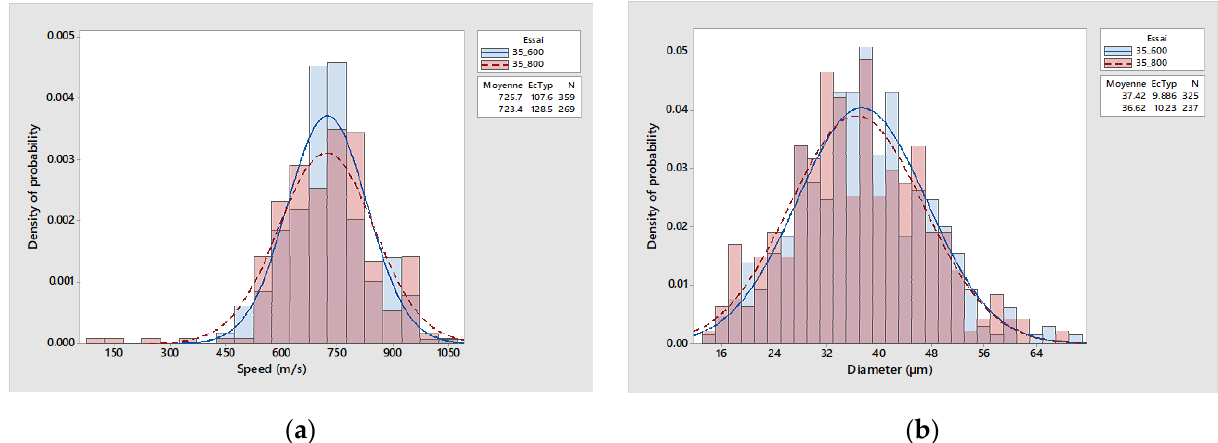
Figure 4. ( a ) Ti 3 AlC 2 particle velocities distribution; ( b ) the corresponding particle density distribution for 3.5 MPa gas pressure and different gas temperatures.